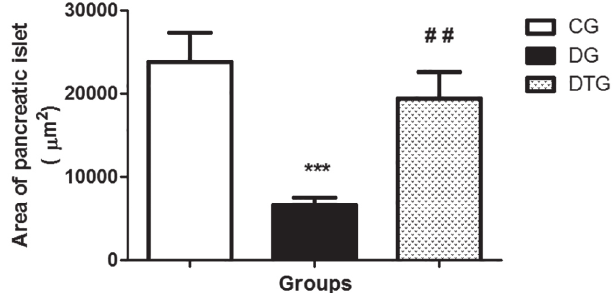
FIGURE 4 - Morphometric analysis of pancreatic islet in CG (control group), DG (diabetic group) and DTG (diabetic Cissampelos sympodialis treatment group). Data appear as mean ± SD ***P < 0.001 in relation to CG versus DG and ## P< 0,01 in relation to DG versus